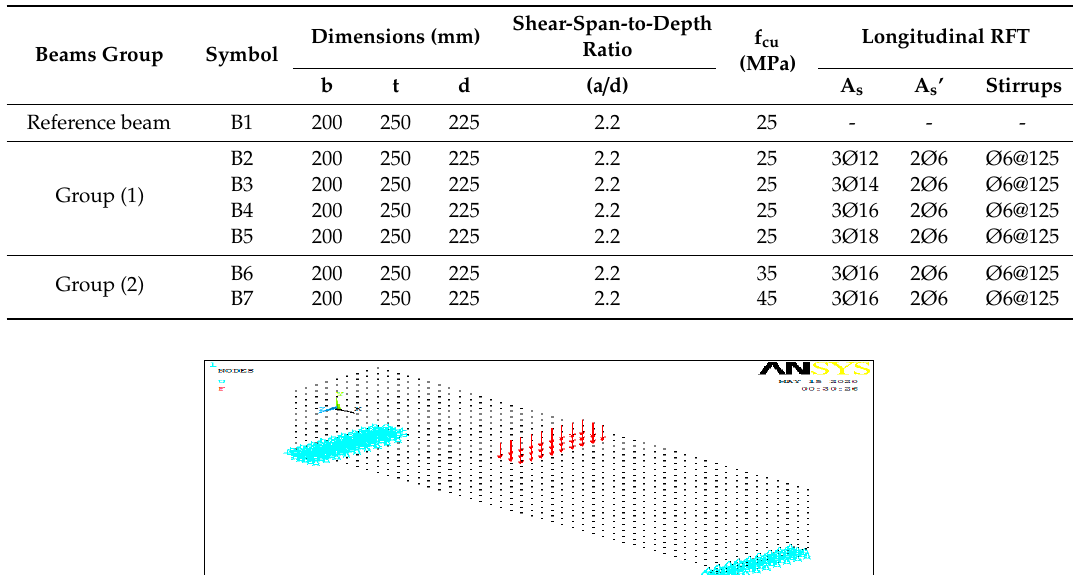
Table 5. Properties of the tested beams.